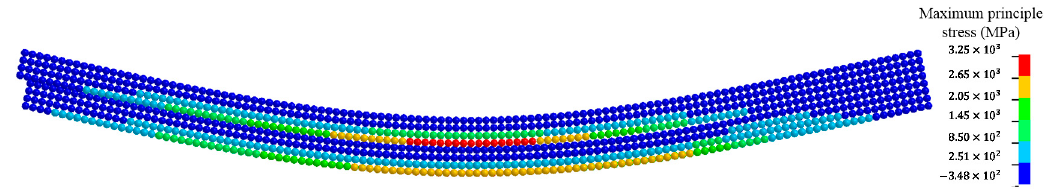
Figure 18. Deformed configuration of the ENF model at t = 30